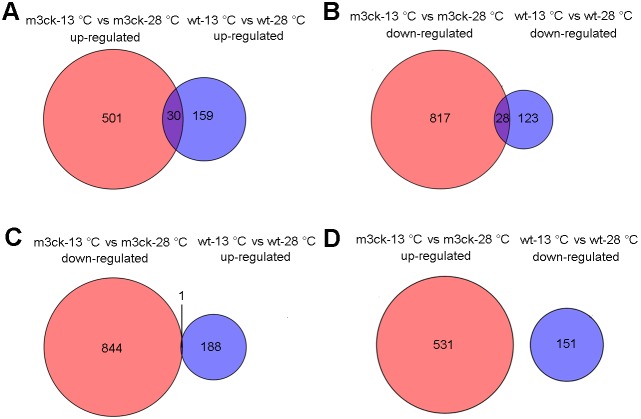
Overlapping expressed transcripts under cold stress.Venn diagrams represent the number of overlapping and differentially expressed genes between A. Up-regulated transcripts under cold stress (2 h) of Tg (smyd1:m3ck) and wild-type fish. B. Down-regulated transcripts under cold stress of Tg (smyd1:m3ck) and wild-type fish. C. Down-regulated transcripts under cold stress of Tg (smyd1:m3ck) and up-regulated transcripts in wild-type fish. D. Up-regulated transcripts under cold stress of Tg (smyd1:m3ck) and down-regulated transcripts in wild-type fish.